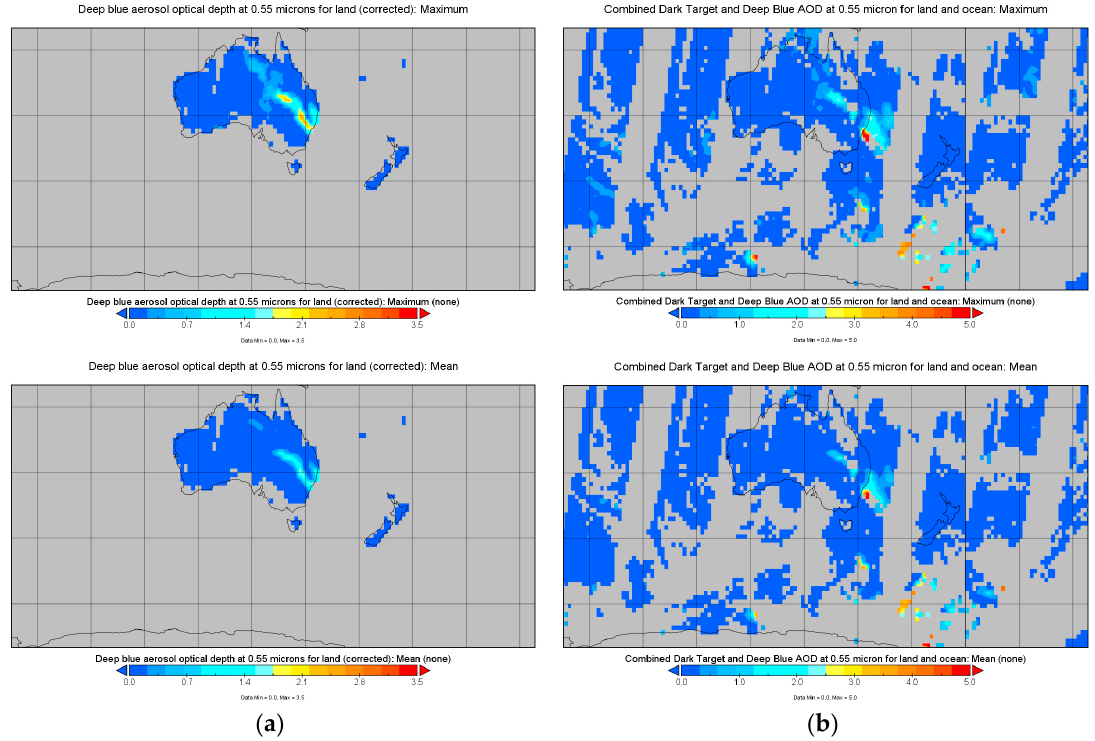
Figure 9. ( a ) Maximum and mean AOD Deep Blue Terra MOD08-D3 for 13 February 2019 and ( b ) combined maximum and mean AOD of Deep Blue (land) and Dark Target (ocean) from Terra MOD08-D3 for 13 February 2019.